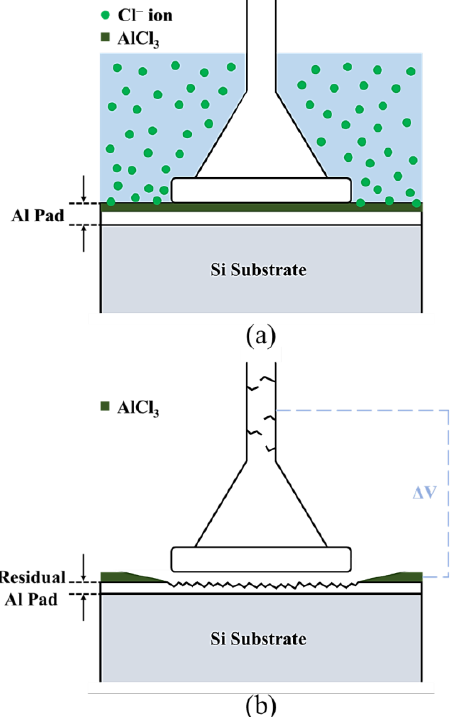
Figure 10. Schematic of the joint of the first bond after chlorination: ( a ) chloride ions corrode the aluminum film; ( b ) the joint of the first bond peels